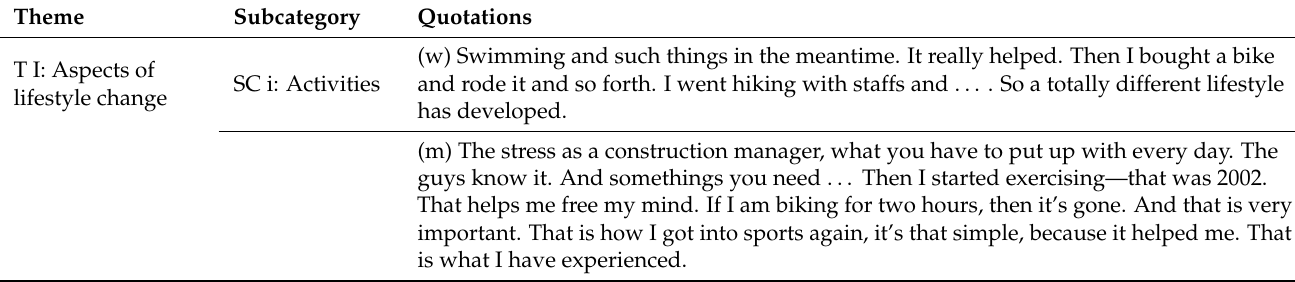
Table 3. Themes and key quotes identified and separated by